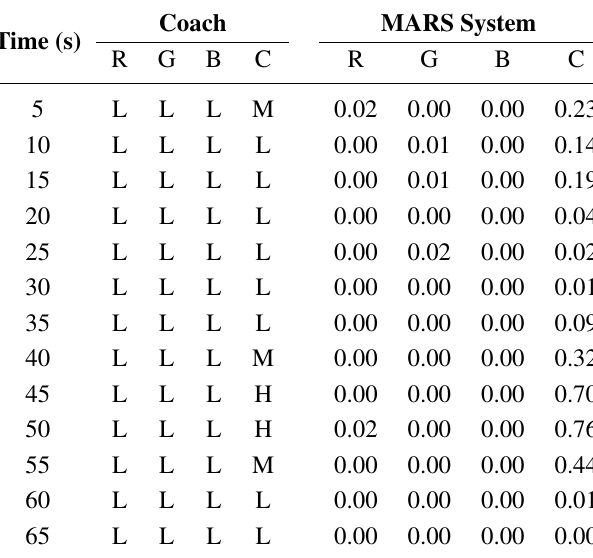
Table 3. Session A , coach and system